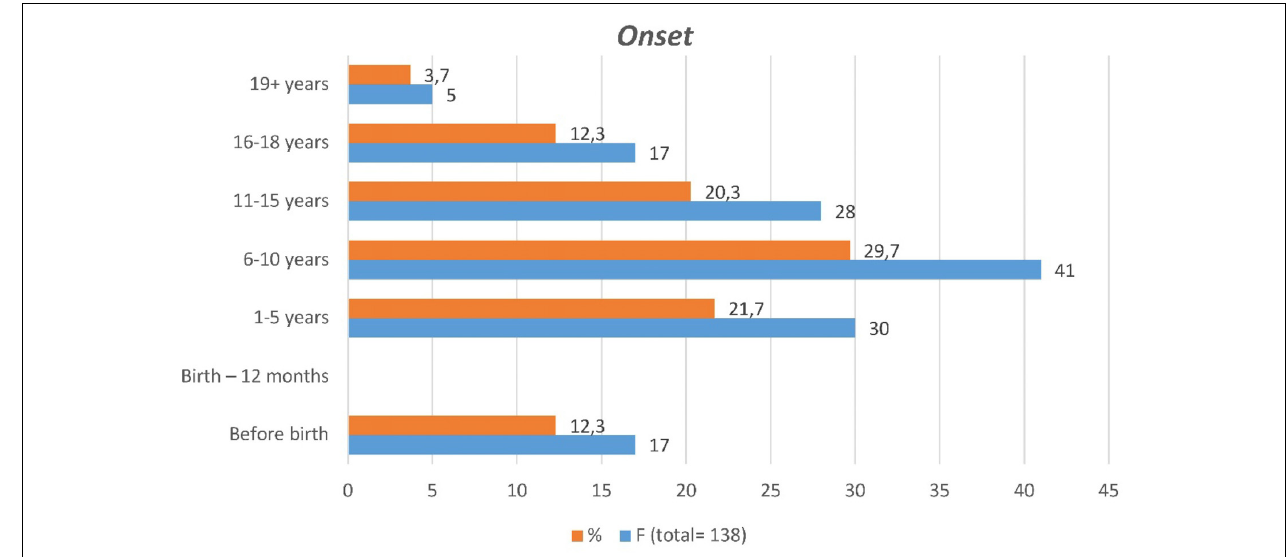
FIGURE 10 | Onset of